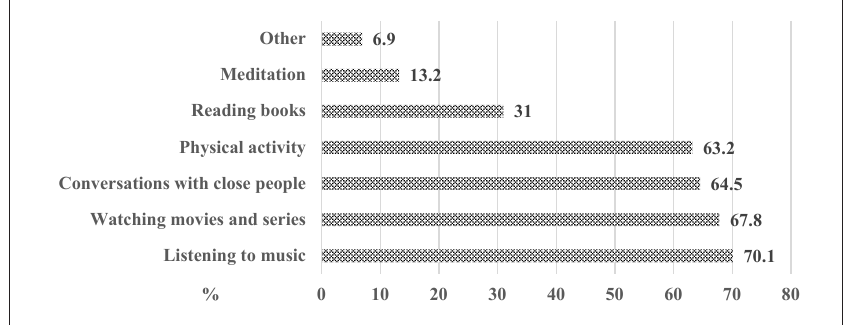
Figure 5. Respondents’ identified